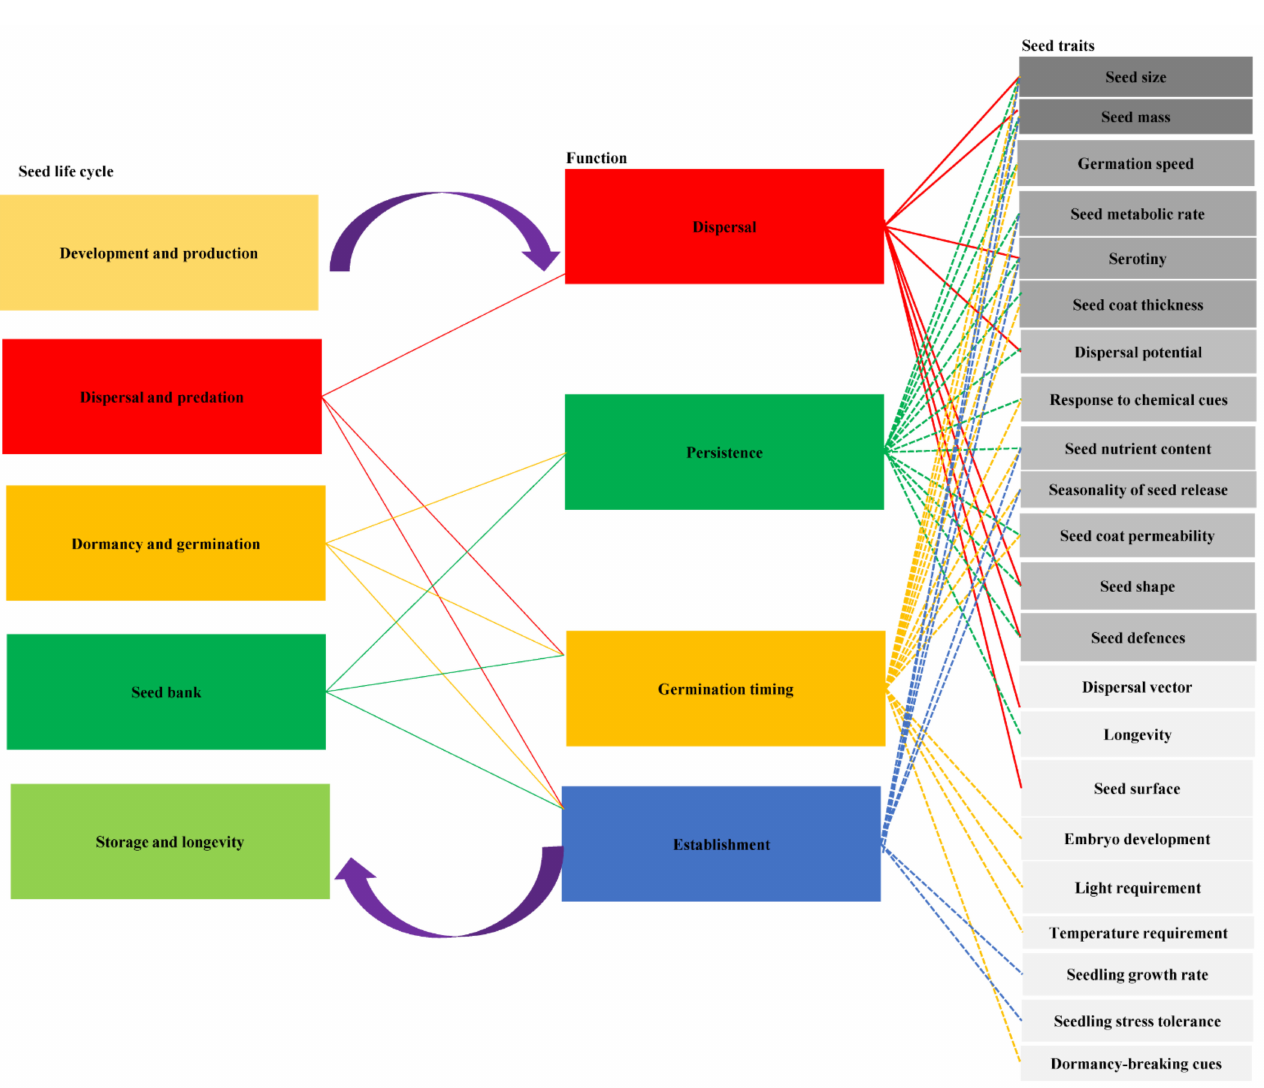
Figure 7. Conceptual graph of network between seed life cycle, seed functions and seed traits. Revised from Saatkamp et al. 2019